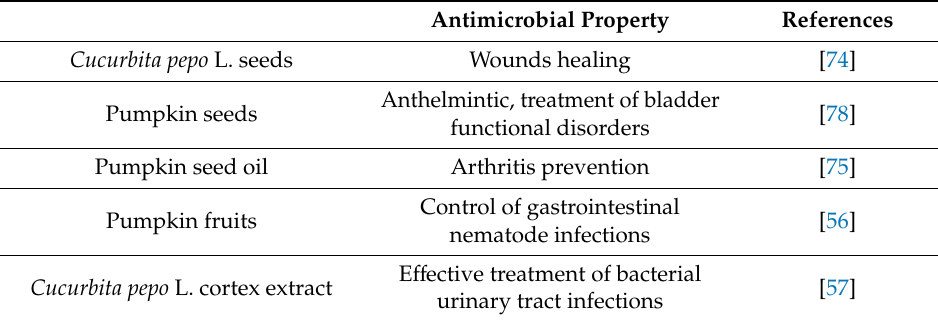
Table 5. Antimicrobial property of Cucurbita spp. and its importance in